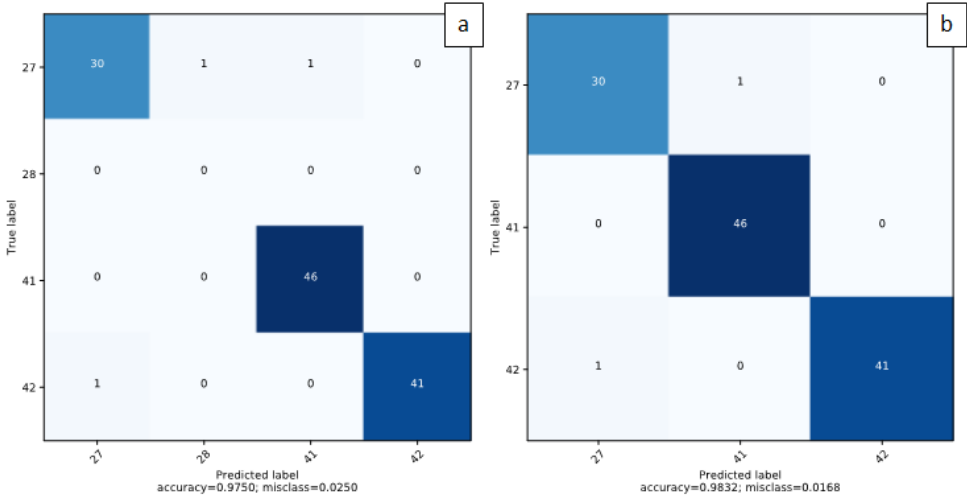
Figure 6. Confusion matrices related to ensemble predictions. ( a ) All output predictions. ( b ) Figure6. Confusionmatricesrelatedtoensemblepredictions. ( a )Alloutputpredictions. ( b )Considering Considering only classes belonging to the test dataset. only classes belonging to the test